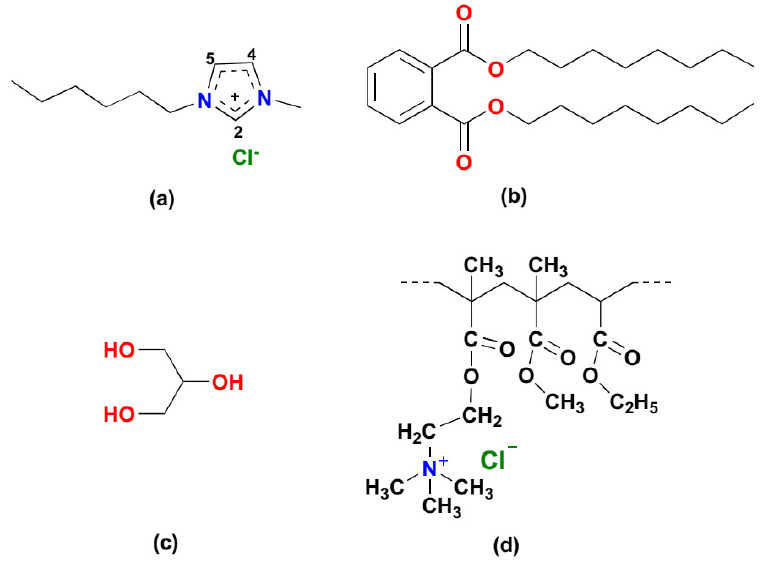
Figure 1. Structure of plasticizers: ( a ) 1-hexyl 3-methyl imidazolium chloride ([HMIM]Cl); ( b ) dioctyl phthalate (DOP); ( c ) glycerol and polymer: ( d ) Eudragit RL 100 or Poly(ethyl acrylate-co-methyl methacrylate-co-trimethylammonioethyl methacrylate chloride.